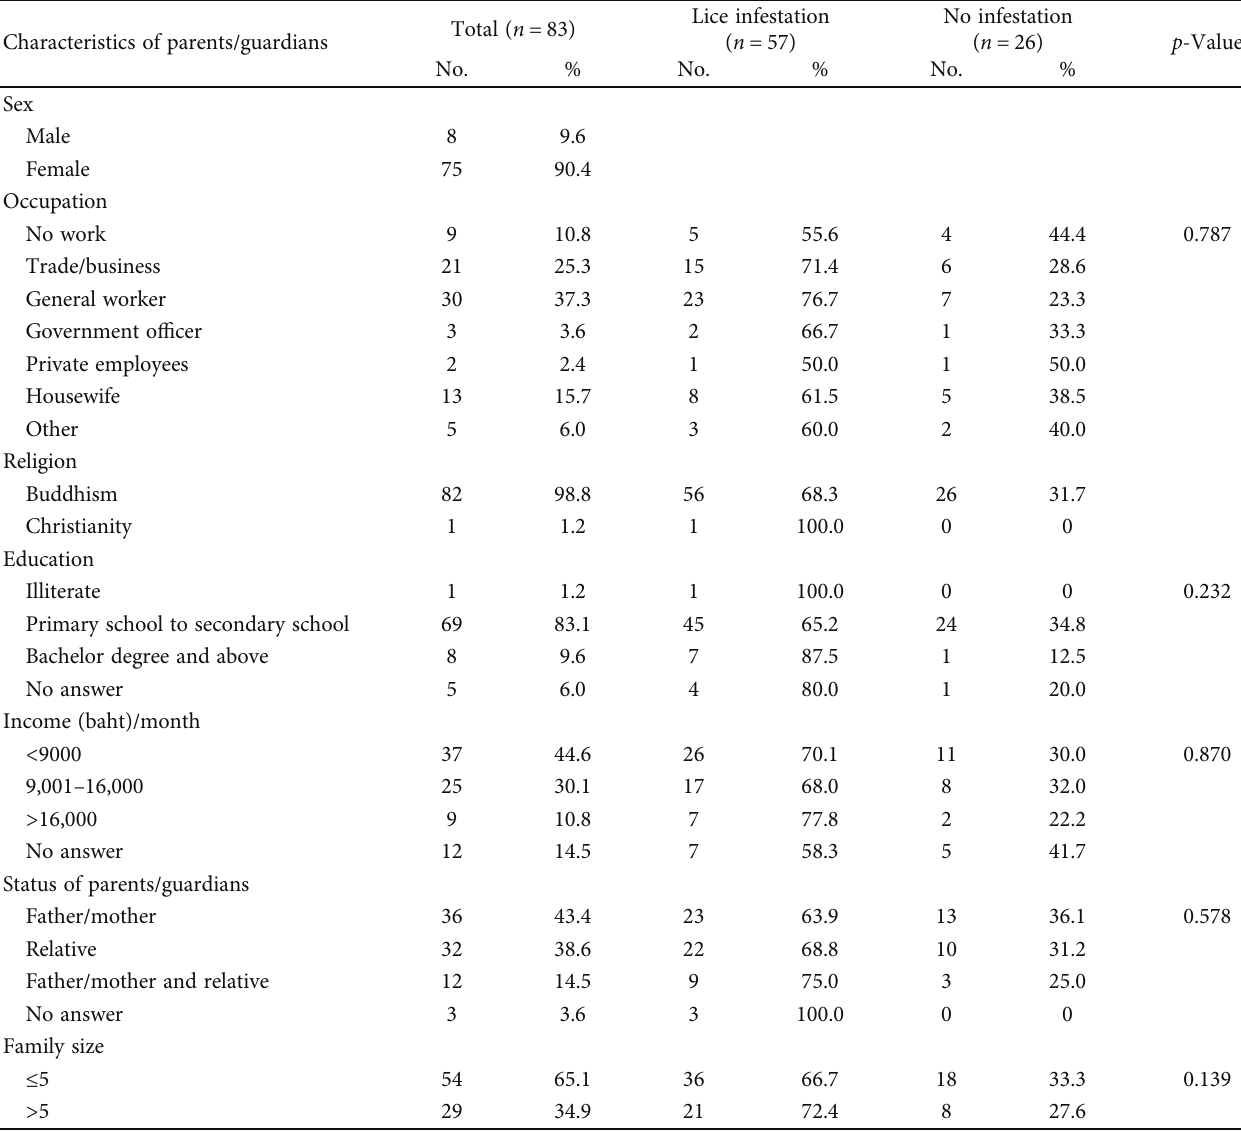
Table 2: General socio-demographic data of parents/guardians and the prevalence of head lice infestation in schoolchildren in Lak Hok subdistrict.